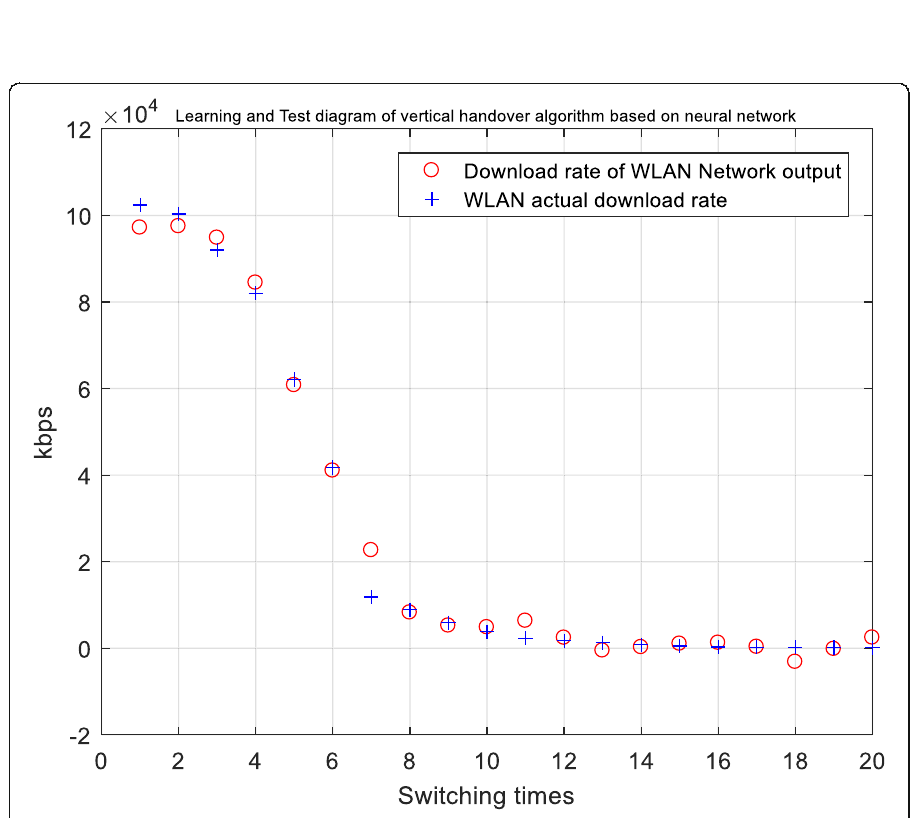
Fig. 9 Contrast curve of data learning and testing in WLAN